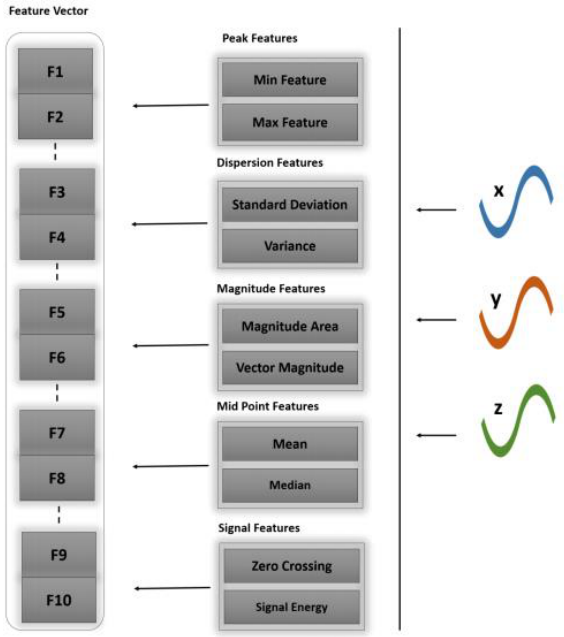
Figure 3. Features vectorized representation of inertial sensor stream components x, y, z.